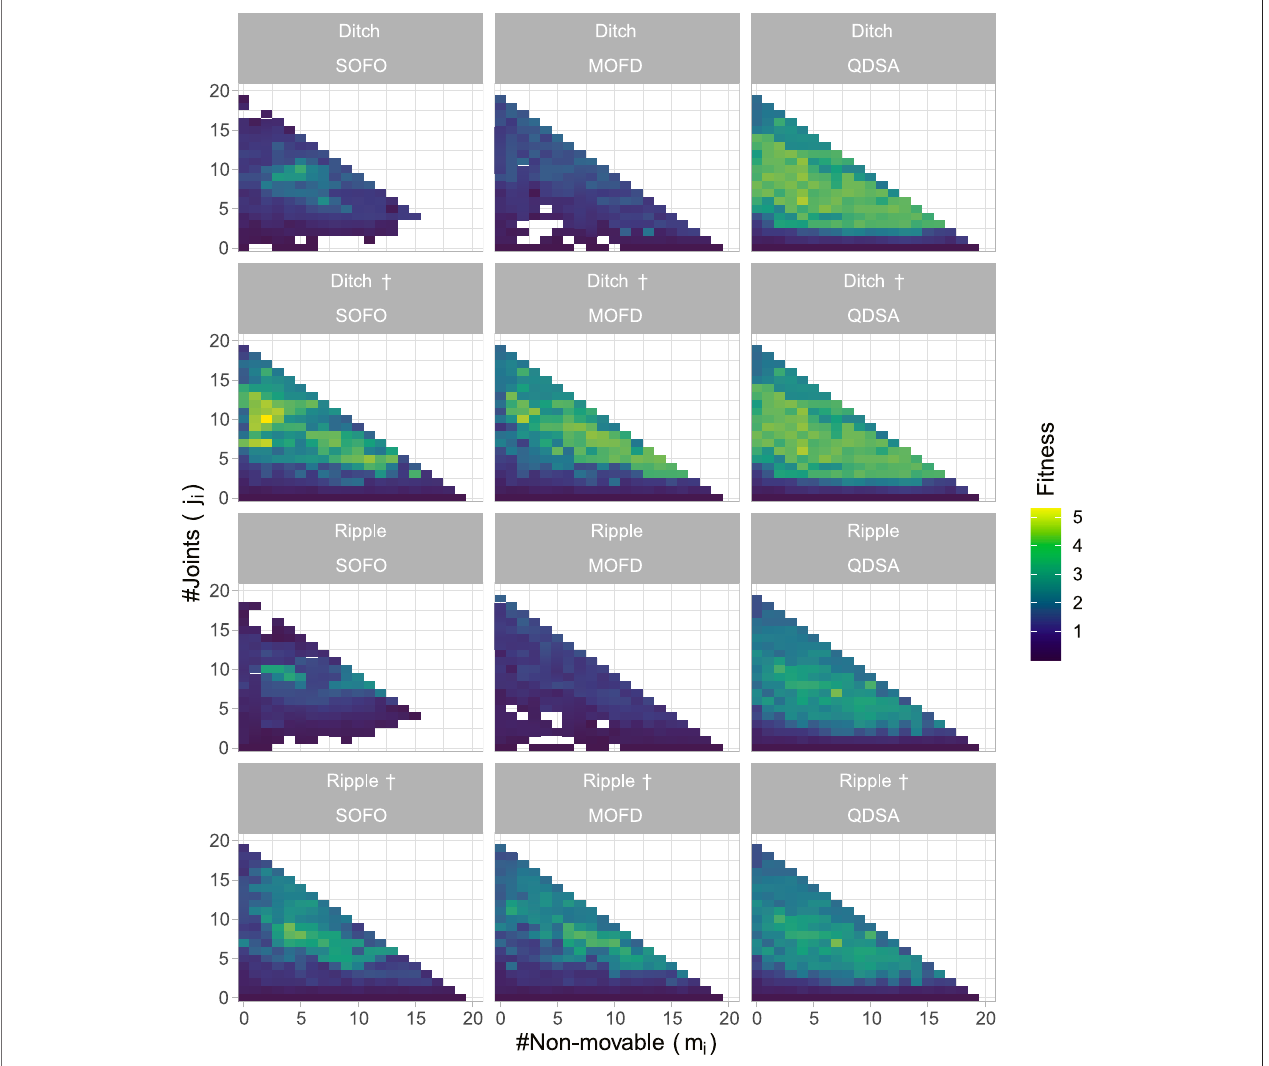
FIGURE 9| Population projection in the differentenvironment settings. The projections show the best solution for each morphological descriptor over all runs after the last evaluation, where color represents fi tness. Environment names with † signify that both SOFO and MOFD were initialized with the result of QDSA from the default fl at